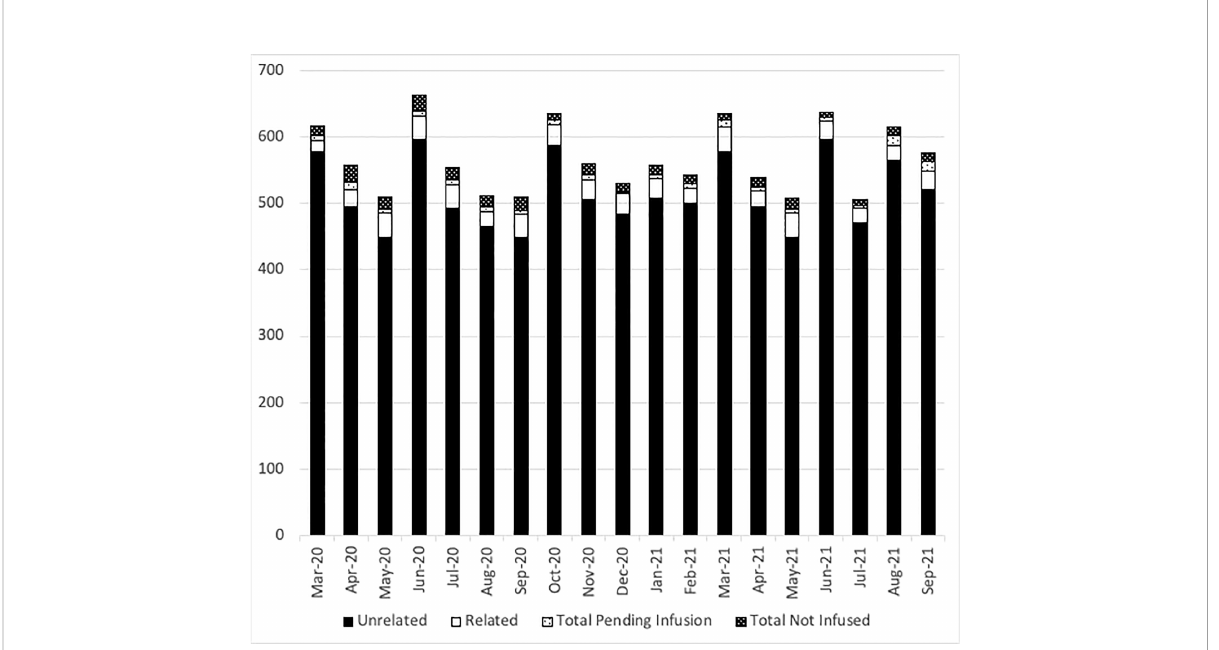
FIGURE 2 The number of NMDP products delivered each month. Black bars show unrelated donor products, open bars show related donor products, light dots show the number of products pending infusion, and dark dots show the number of products not infused each month from March 2020